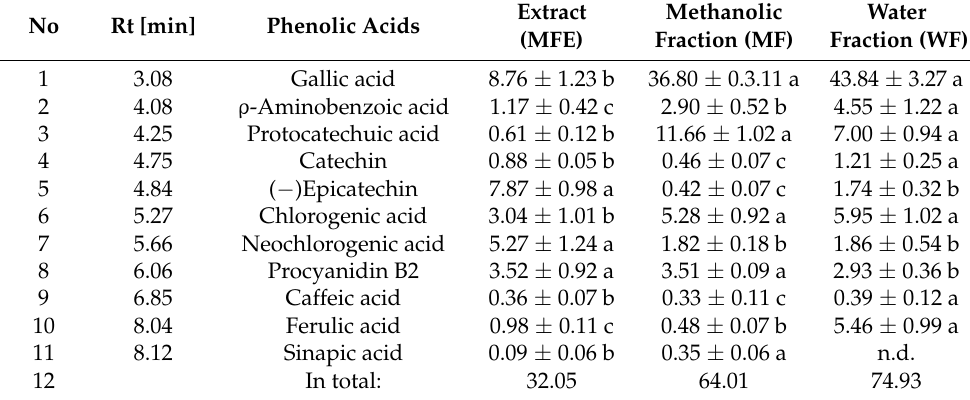
Table 4. Profile of phenolic compounds quantified [mg/1 g of dry extract] in the tested extracts.